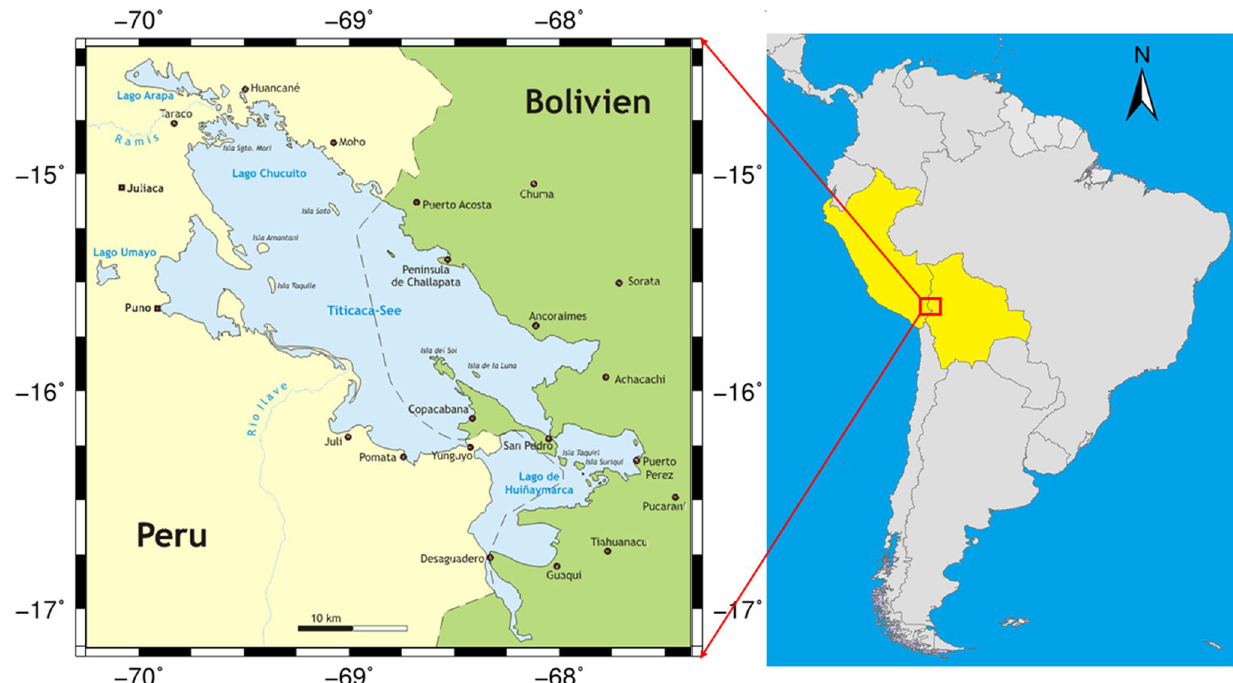
Fig. 1 Location of the study area